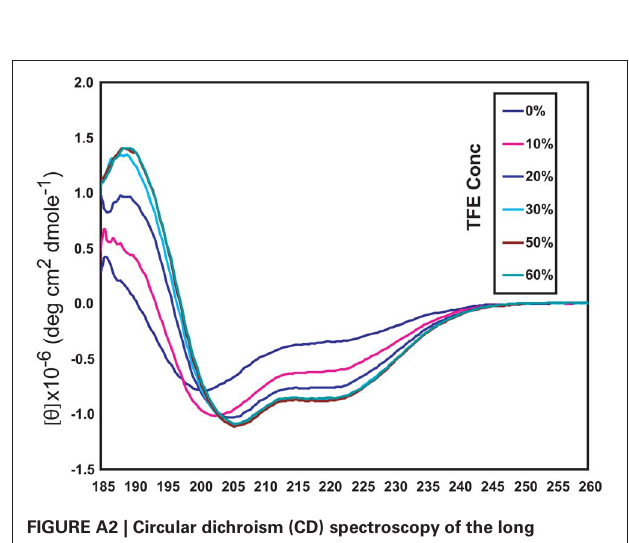
Predictions were calculated with the web-server DISOPRED2 (http://bioinf.cs.ucl.ac.uk/disopred/) and PSIPRED (http://bioinf.cs.ucl.ac.uk/psipred).